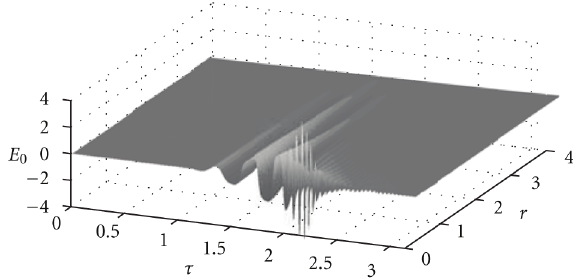
Figure 3: Self-focusing of a pulse for small normal dispersion ( B = 0 . 0001) when z = 1. Compression in the transverse direction is apparent in the back ( τ large) of the pulse.